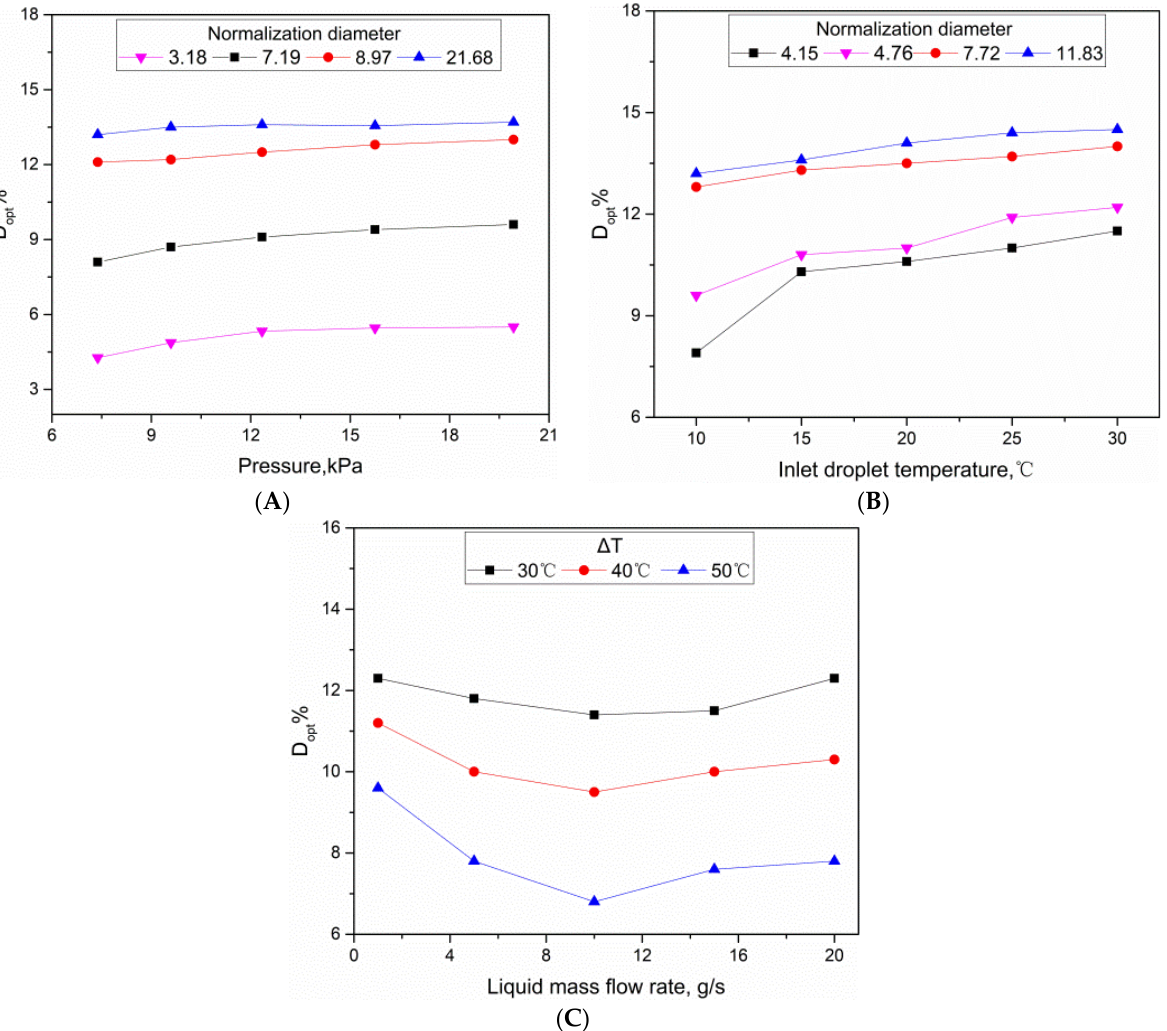
Figure 9. In fl uence of pressure ( A ), droplet temperature ( B ), and liquid mass fl ow rate ( C ) on the Figure 9. Influence of pressure ( A ), droplet temperature ( B ), and liquid mass flow rate ( C ) on the D opt D opt .